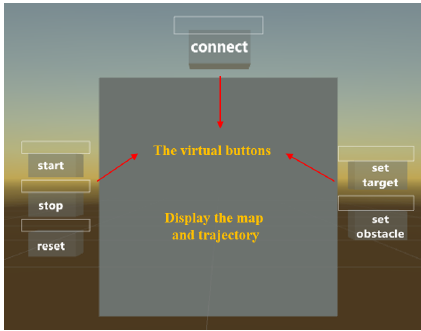
Figure 6. The virtual panel in Unity3D.